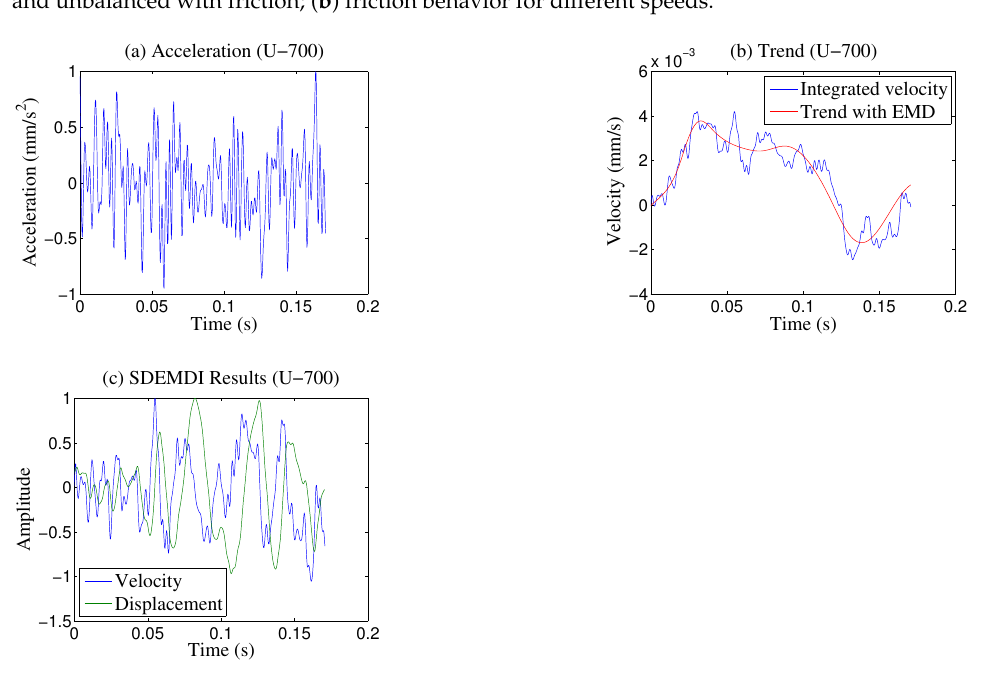
Figure 7. ( a ) Comparison of signal for three different disk conditions at 900 rpm: free, unbalanced, and unbalanced with friction; ( b ) friction behavior for different speeds.